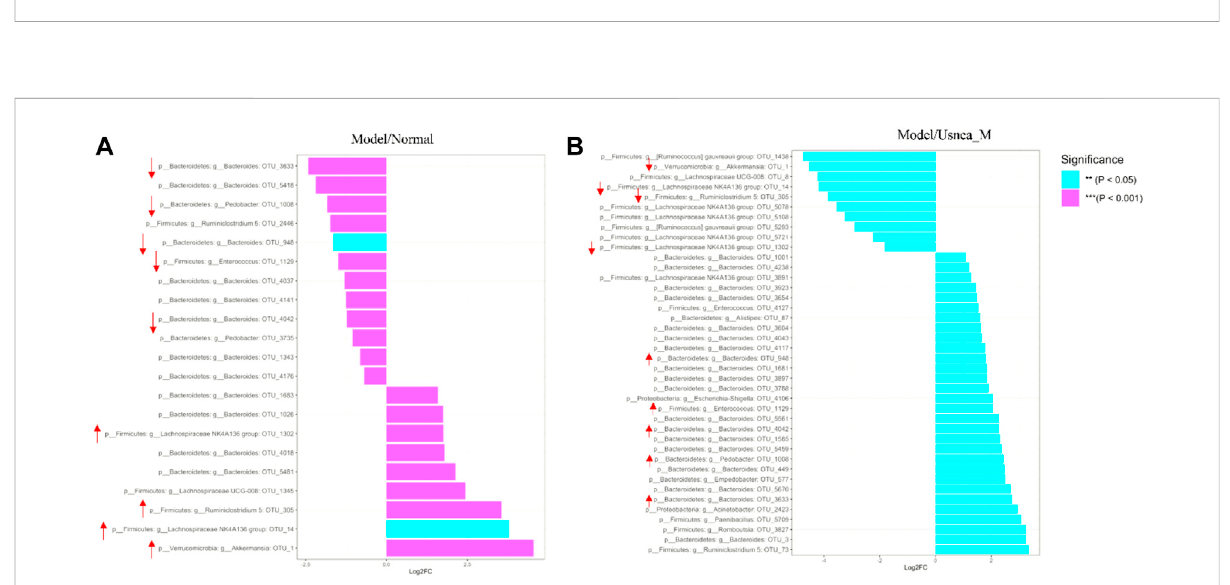
FIGURE 8 Relative abundance of organisms at the phylum and genus levels in the intestinal fl ora. (A) Relative abundance of the top 10 enteric fl ora at the phylum level; (B) relative abundance of the top 10 enteric fl ora at the genus level. Note: Values are expressed as mean ± SD ( n = 3 per group). Different colors represent different enteric fl ora.